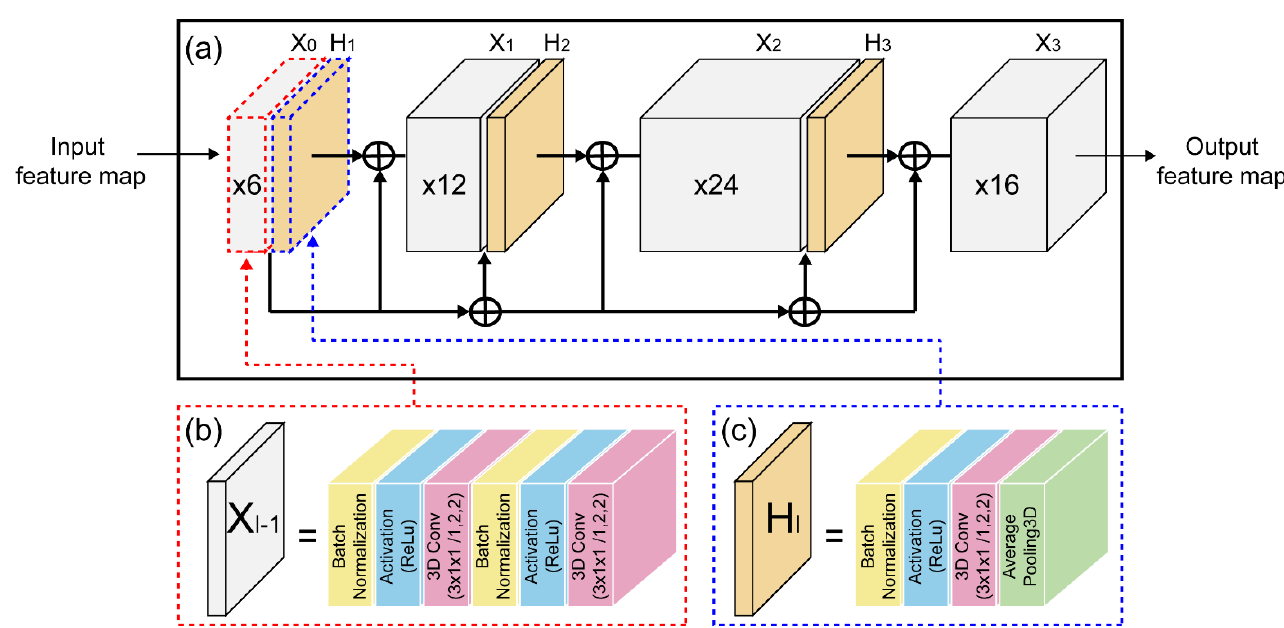
Figure 2. Details of 3D dense connection CNN architecture: ( a ) dense connection CNN; ( b ) dense block layer structure; and ( c ) transition layer structure.